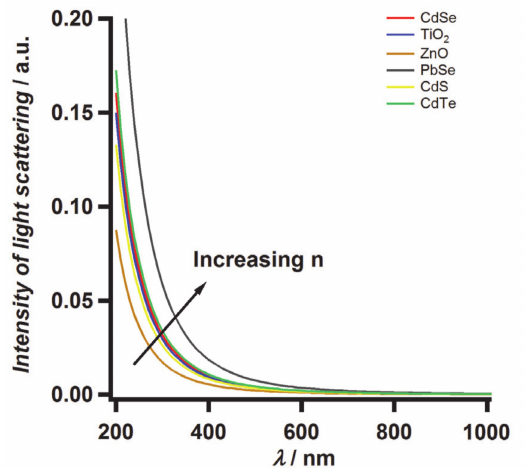
Figure 7. Rayleigh scattering of semiconductors as a function of wavelength, as determined by employing Equation (4). The arrow indicates the effect of increasing of refractive